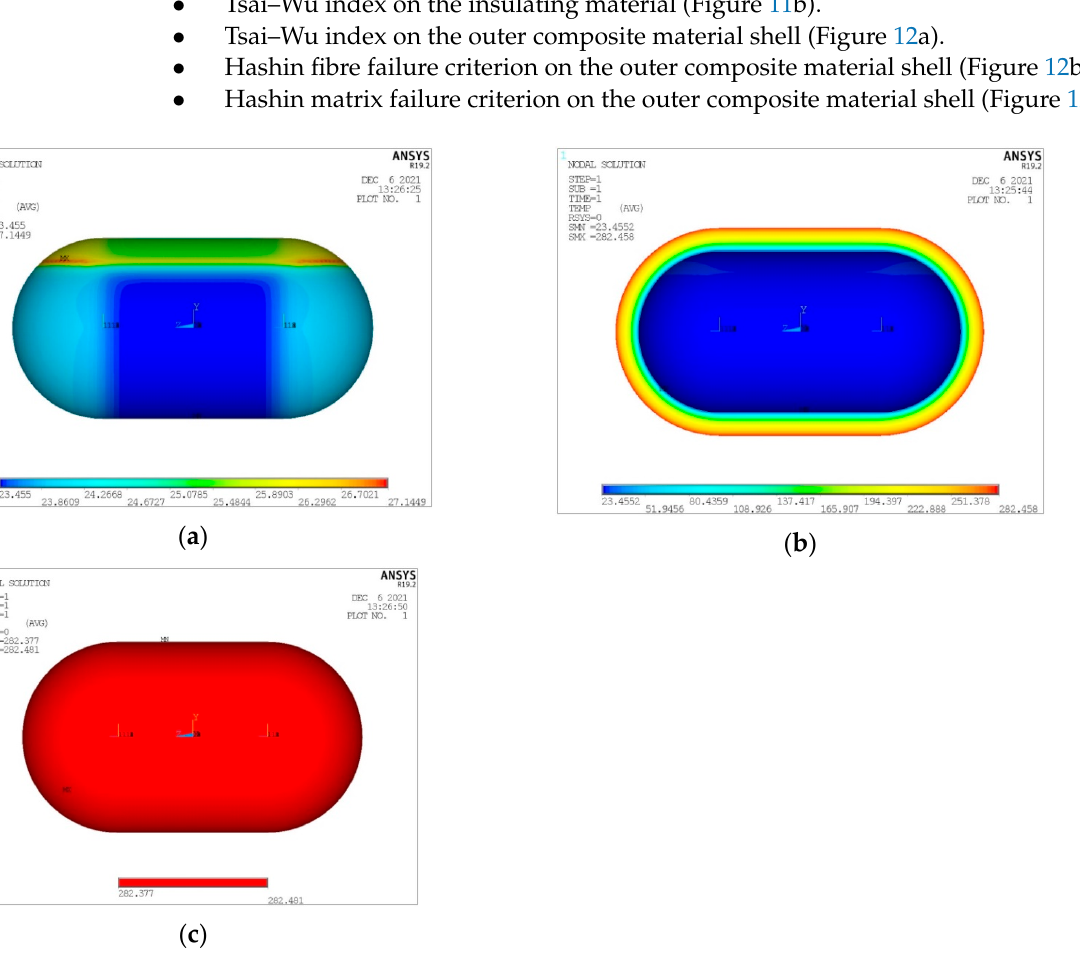
Figure 9. Temperature distribution for ( a ) inner aluminum shell, ( b ) insulating material, ( c ) outer composite shell.